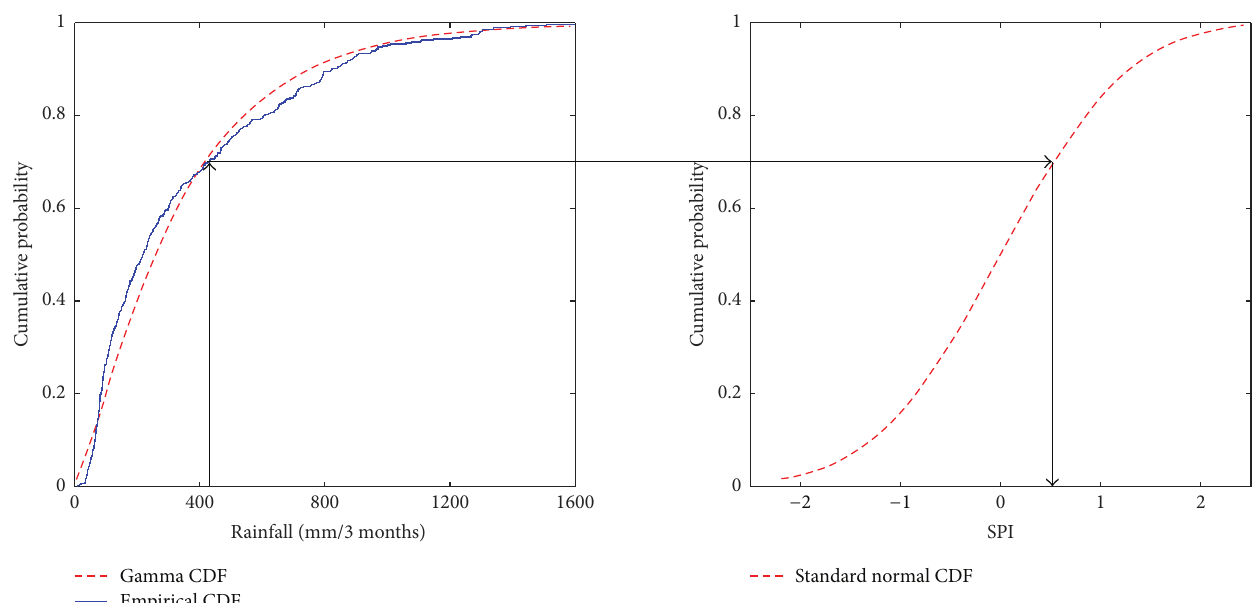
Figure 2: An example of (equiprobability) transformation of the three-month precipitation for Seoul from cumulative probability of fitted gamma cumulative distribution into normal random variable 𝑍 (SPI) with mean zero and variance one.